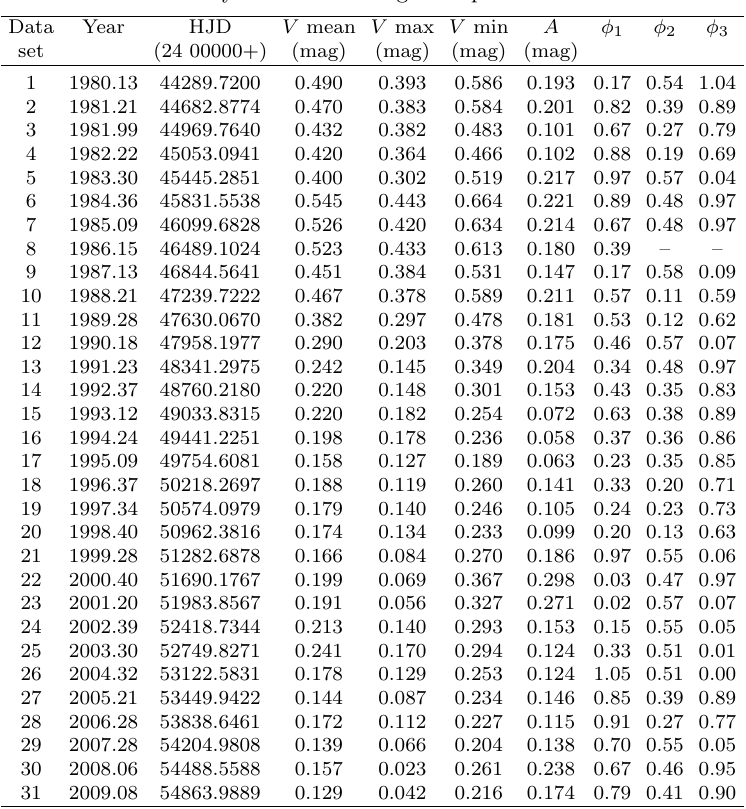
Table 2. The analysis results of long-term photometric